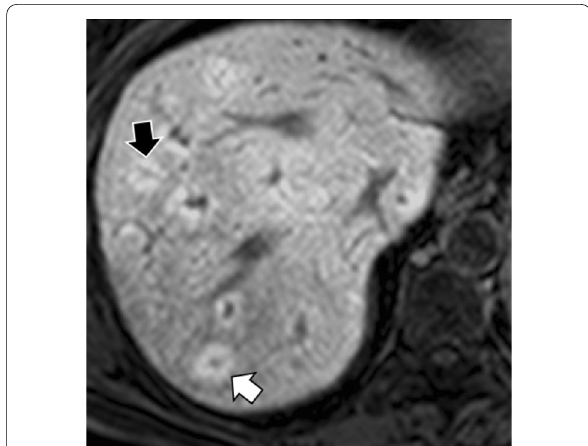
Fig. 17 A 57‑year‑old woman with secondary sclerosing cholangitis and periportal hyperintensity on hepatobiliary phase. Gadoxetate disodium‑enhanced MRI shows both thick tramline‑like periportal hyperintensity (black arrow) and nodular‑like periportal hyperintensity (white